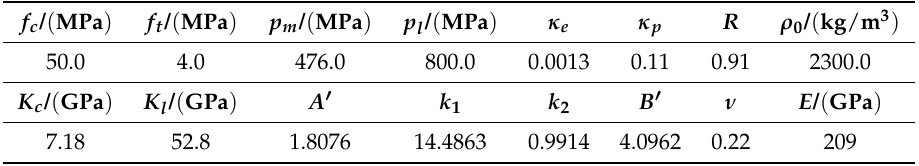
Table 1. The parameters of concrete used in